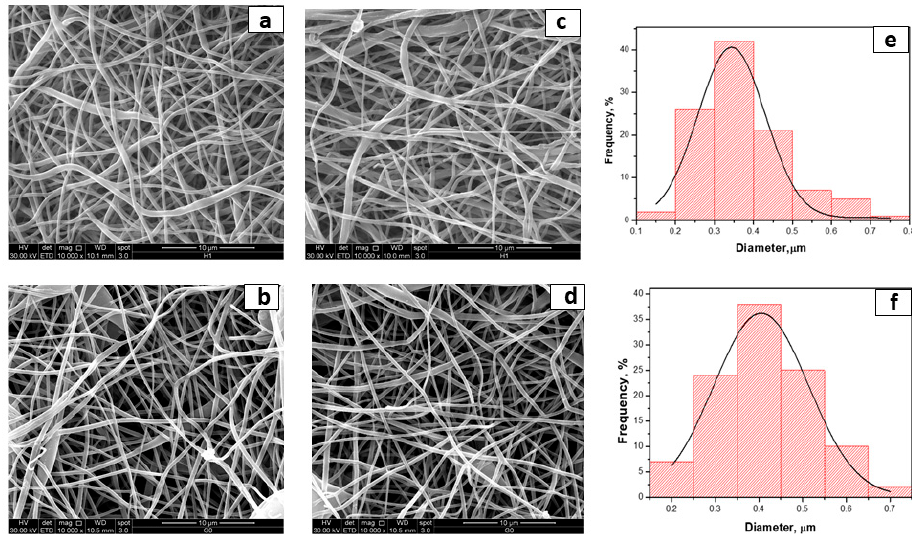
Figure 1. SEM photographs of ( a ) PCL; ( b ) PCL-PLA; ( c ) PCL-Cur; ( d ) PCL-Cur/PLA; ( e ) fiber distribution of PCL-Cur and ( f ) fiber distribution of PCL-Cur/PLA.